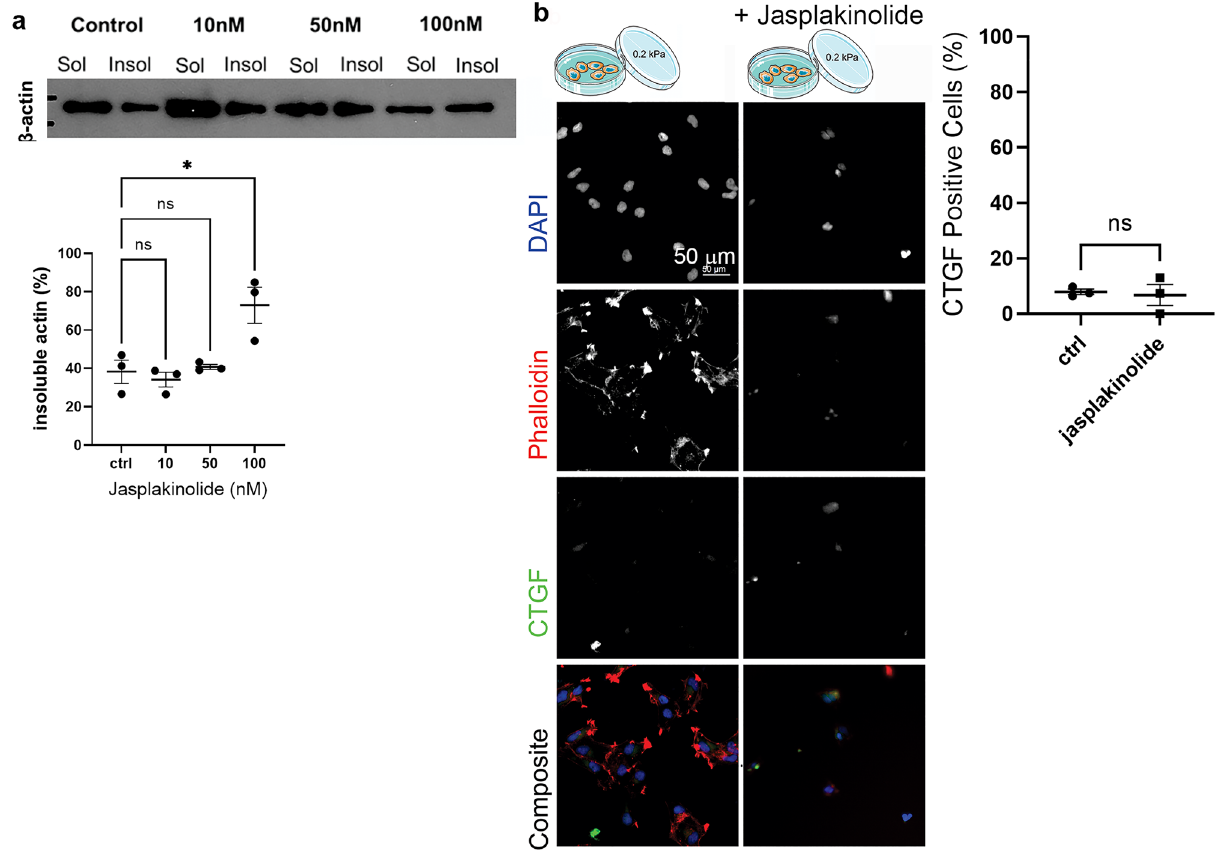
Figure 5. Mechanosensitive CTGF expression is independent of actin organization. ( a ) The concentration of Jasplakinolide required to stabilise actin filaments was determined by western blot analysis of the insoluble versus soluble β-actin fraction following incubation with the indicated concentrations of Jasplakinolide in cells grown on tissue culture plastic. Data points on the graph represent the insoluble actin as a percentage of total actin, collated from 3 biological repetitions. Error bars indicate ± SEM. Symbols denote statistical significance: *p < 0.05; NS = not significant (p < 0.05); One-way ANOVA with Tukey’s post-comparison test. ( b ) WK1 cells cultured on 0.2 kPa PAGs and grown in the presence of vehicle (first column of images) or 100 nM Jasplakinolide (second column of images) for 1 h, as per the schematic. Cells were fixed and immunostained with anti-CTGF, DAPI to detect cell nuclei and phalloidin to detect F-actin—shown individually in grey scale and as a colour overlay in the final row. Data points on the graph show the percentage of CTGF positive WK1 cells after an hour of culture on 0.2 kPa PAGs in the presence of vehicle (control) or 100 nM Jasplakinolide from 3 independent replicates. Error bars indicate ± SEM. Symbols denote statistical significance: N = not significant (p < 0.05); unpaired